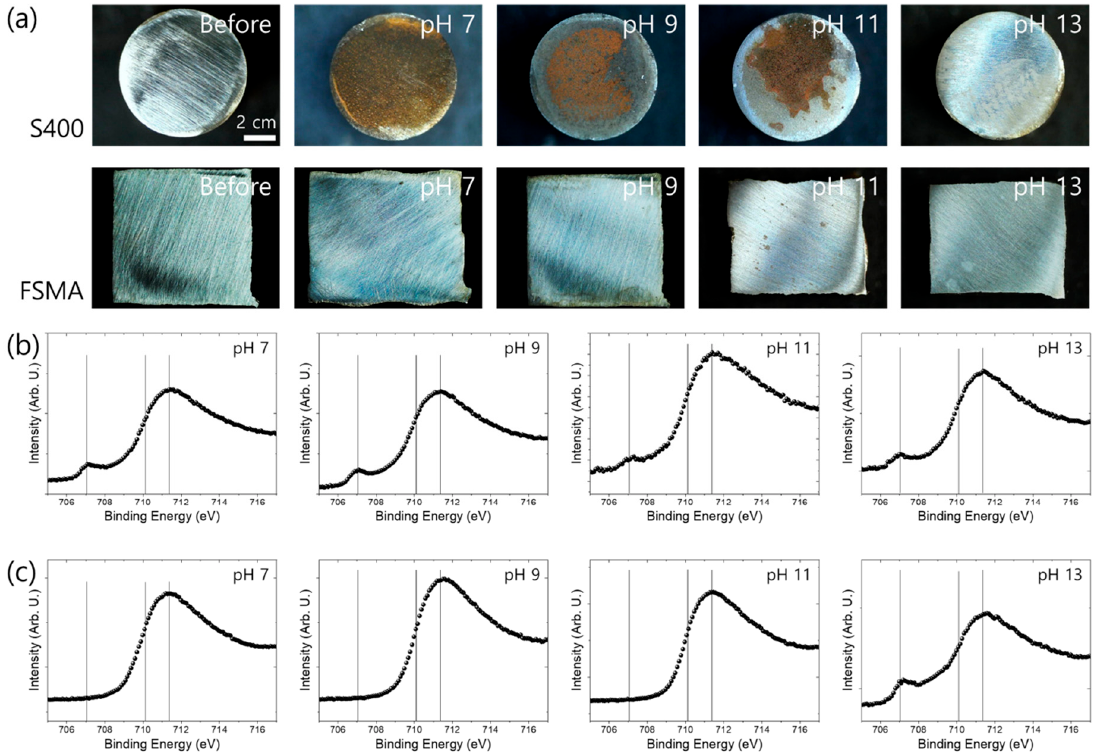
Figure 4. ( a ) Optical images of S400 and Fe-based shape memory alloy immersed in deionized water for a day with various pH values, adjusted by CaO. XPS core-level spectra of Fe 2p3/2 of ( b ) FSMA and ( c ) S400 immersed in deionized water for a day with various pH values, adjusted by CaO.